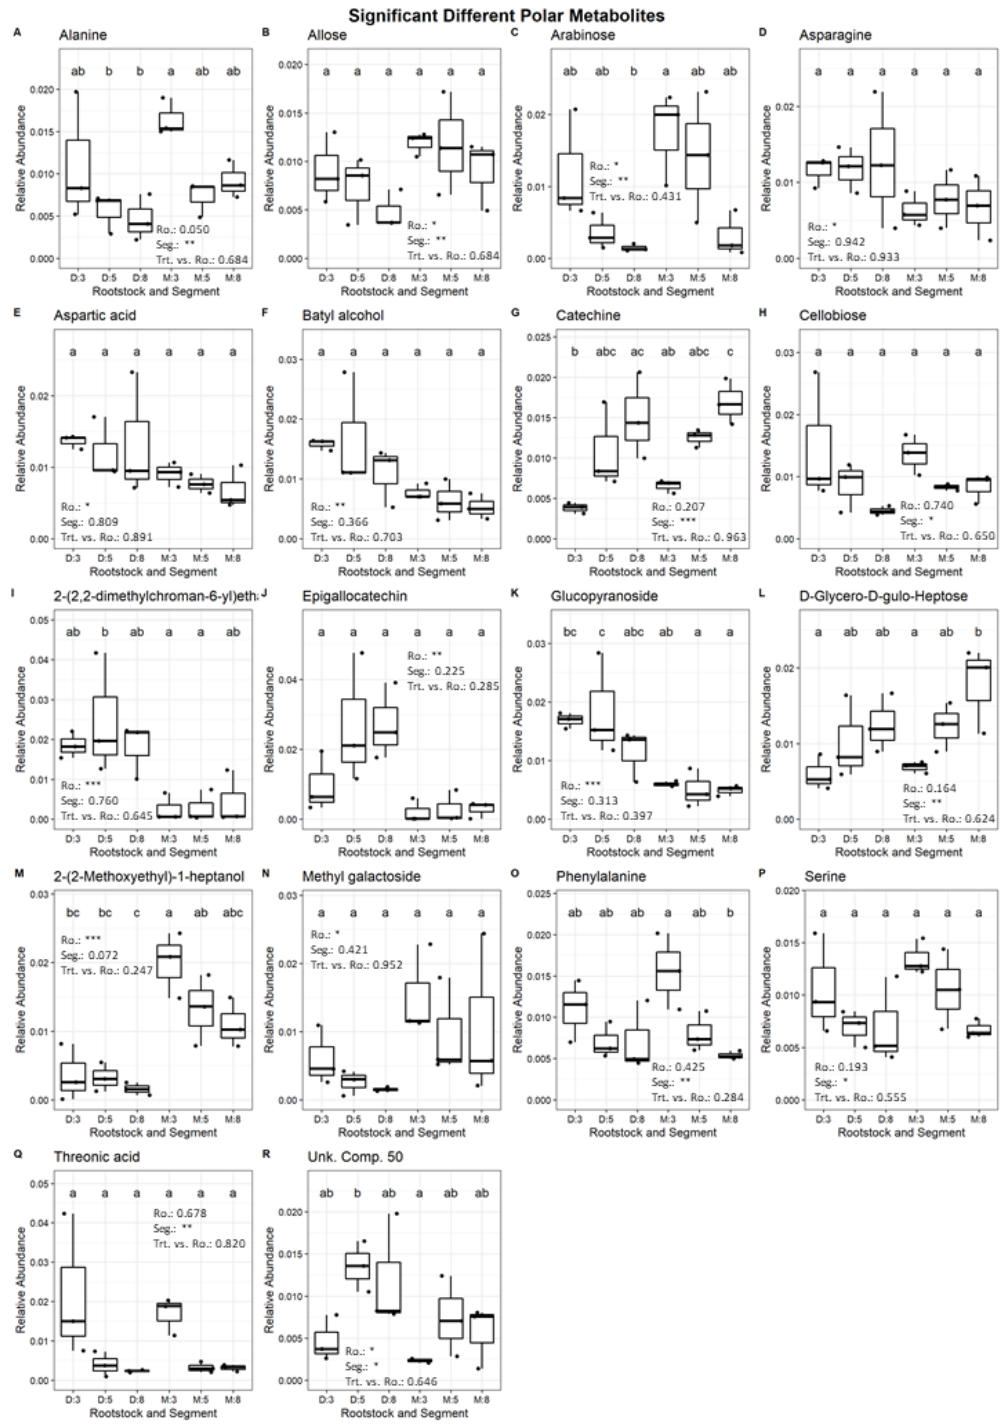
Figure 4. Boxplots of polar metabolites with significant differences (Alanine ( A ), Alose ( B ), Ara- binose ( C ), Asparagine ( D ), Aspartic acid ( E ), Batyl alcohol ( F ), Catechin ( G ), Cellobiose ( H ), 2– (2,2–dimethylchroman–6–yl)ethanol ( I ), Epigallocatechin ( J ), Glucopyranoside ( K ), D–Glycero–D– gulo–Heptose ( L ), 2–(2–Methoxyethyl)–1–heptanol ( M ), Methyl galactoside ( N ), Phenylalanine ( O ), Serine ( P ), Threonic acid ( Q ) and Unknown Compound 50 ( R )) between segments (3, 5 and 8 cm, Seg.) and/or treatments (“Dusa” or “Mexicola” Rootstock, Ro.) by a two-way ANOVA analysis. Text in plot are the p-values of the two-way ANOVA analysis ( p < 0.05 (*), <0.01 (**), <0.001 (***)). Letters are results of Tukey’s HSD